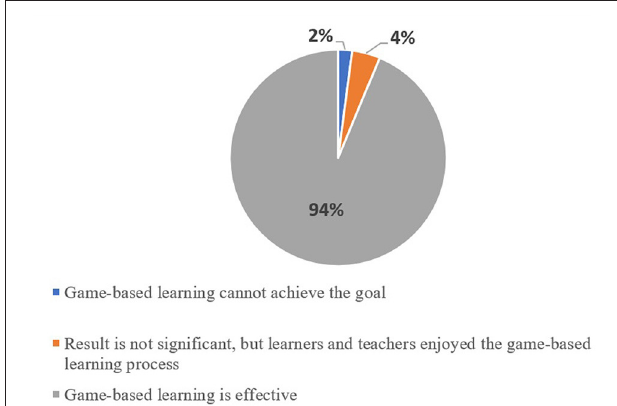
FIGURE 8 | Distribution of outcomes based on the efficacy of game-based